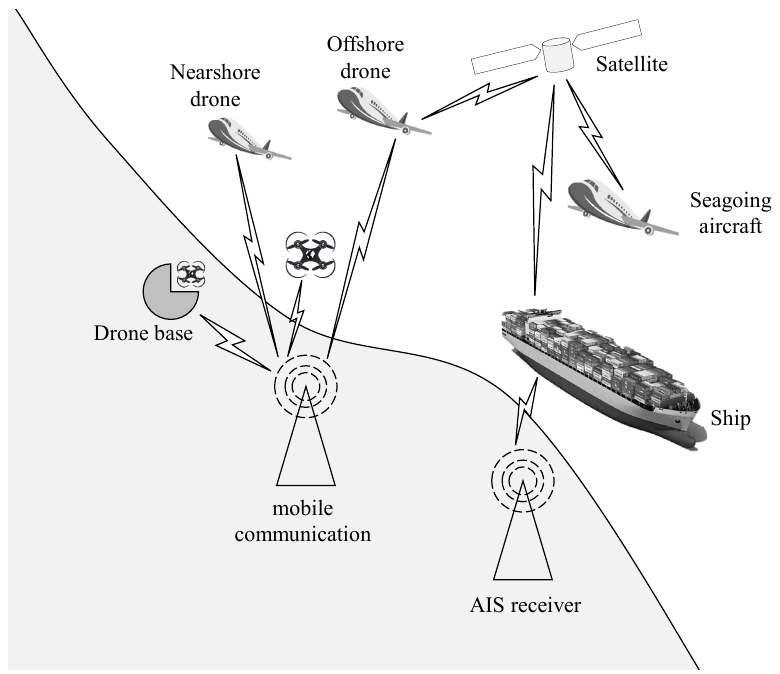
Figure 1. A conceptual diagram of the cyber-physical system.